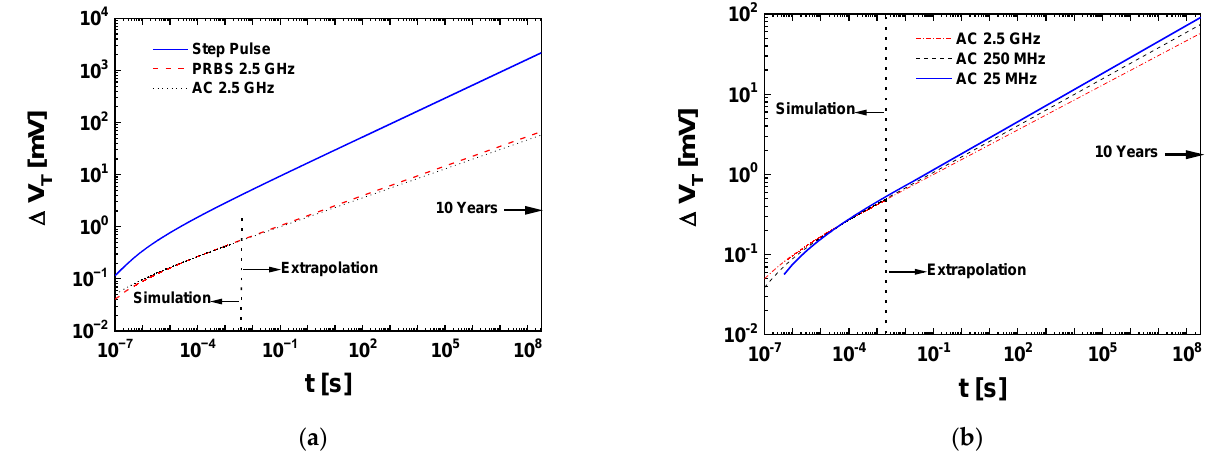
Figure 4. Simulated threshold voltage shift Δ V T as a function of time for ( a ) step pulse, 2.5 GHz PRBS and AC pulse, ( b ) 2.5 GHz, 250 MHz and 25 MHz AC pulse [26] .